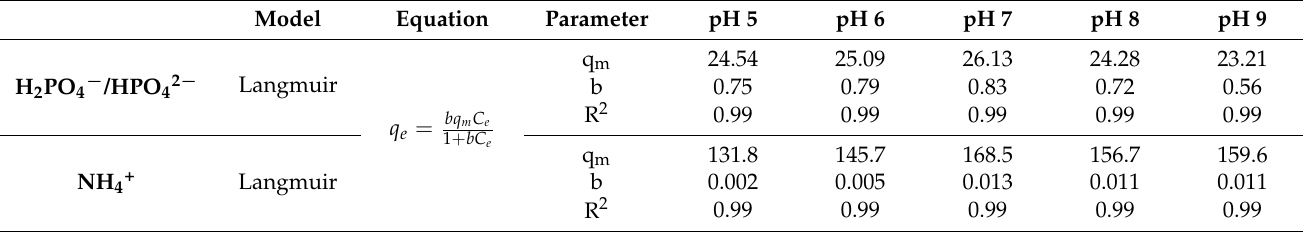
Table 1. The constants of Langmuir and R 2 for adsorption of phosphates and ammonium on novel f -MB at pH 5–9.